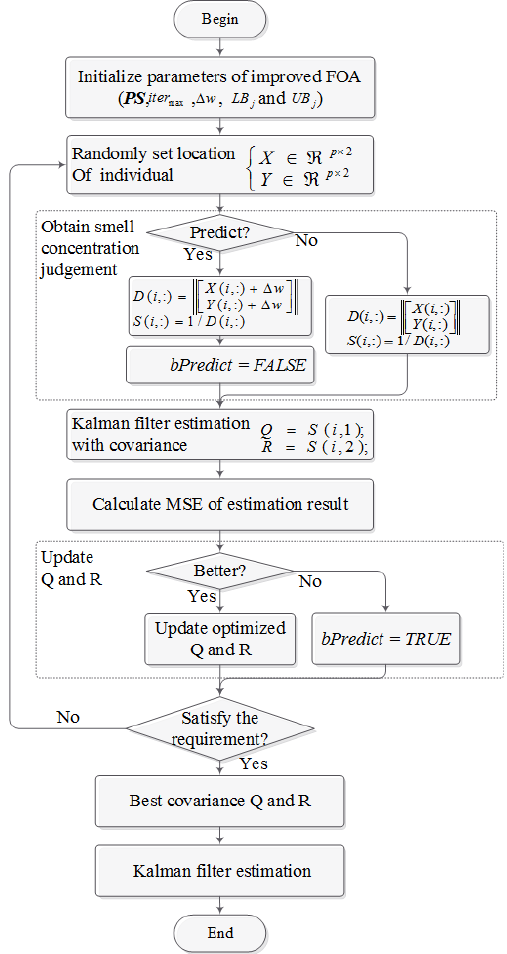
Figure 5. The flowchart of the IFOA ‐ KF.